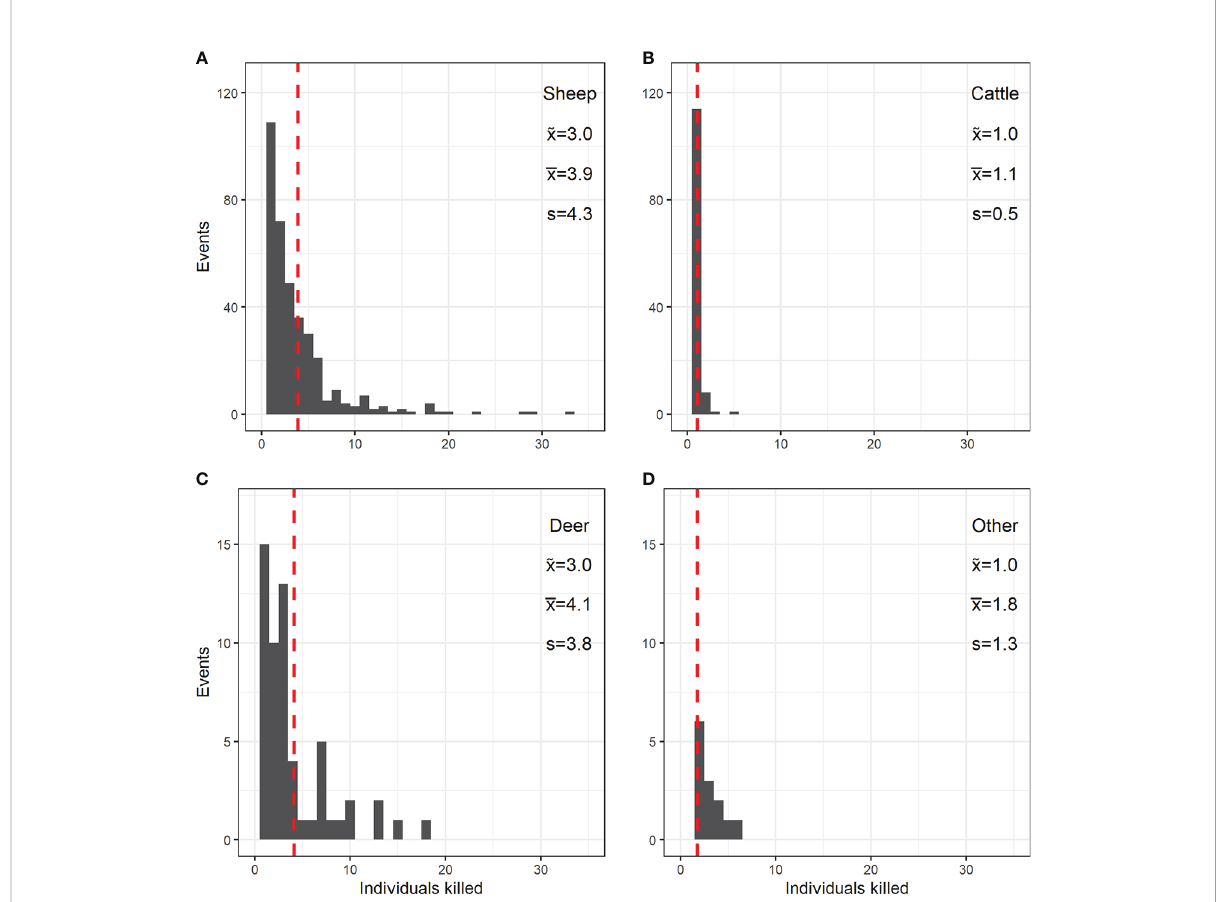
FIGURE 5 Distribution of number of livestock individuals [ (A) sheep; (B) cattle, (C) farmed deer, and (D) other livestock species] killed by wolves in Brandenburg state (Germany) from 2007 to 2020 according to reported wolf predation events. To describe the distribution for each species category, we report the median (x), the mean ( e x; this value is plotted as dashed red line), and the standard deviation (s). Note the different y- scales in the upper and lower